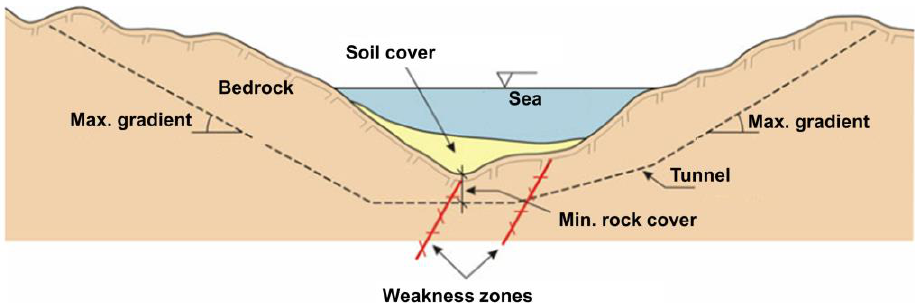
Figure 28. Typical longitudinal section of a subsea tunnel [75].